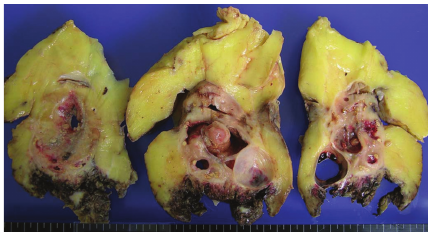
F 2: e transverse section of the le kidney aer formalin �xationrevealedthedilatedcollectingsystemandthincortex,which were surrounded by yellowish fatty tissue.